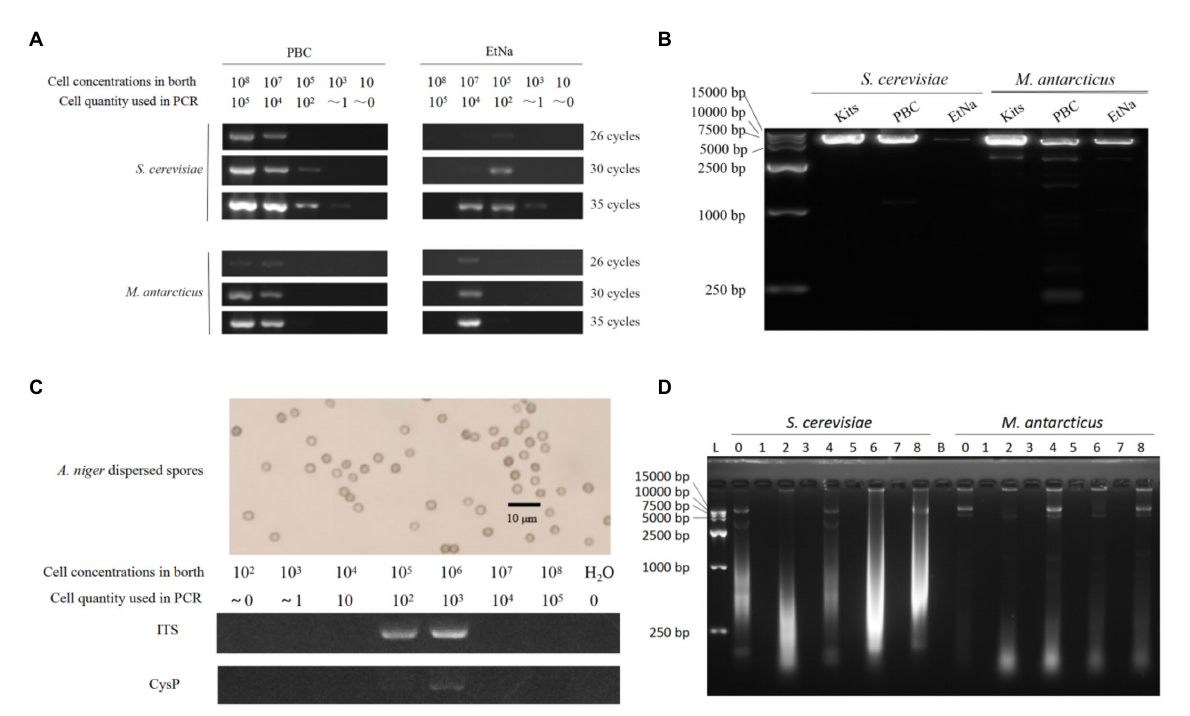
FIGURE 2 PBC applications (A–C) and its inability to precipitate free DNA (D) . (A) Comparison between PBC and EtNa methods for treating different cell density samples. S. cerevisiae and M. antarcticus samples of different cell densities were treated by PBC and EtNa, respectively. The templates were then tested by PCR amplification using ITS primers with 26, 30, and 35 PCR amplification cycles. (B) Comparing the amplification efficiencies of long DNA fragment from the templates made by commercial kits ， PBC and EtNa, respectively. Single copy DNA fragments of about 6.5